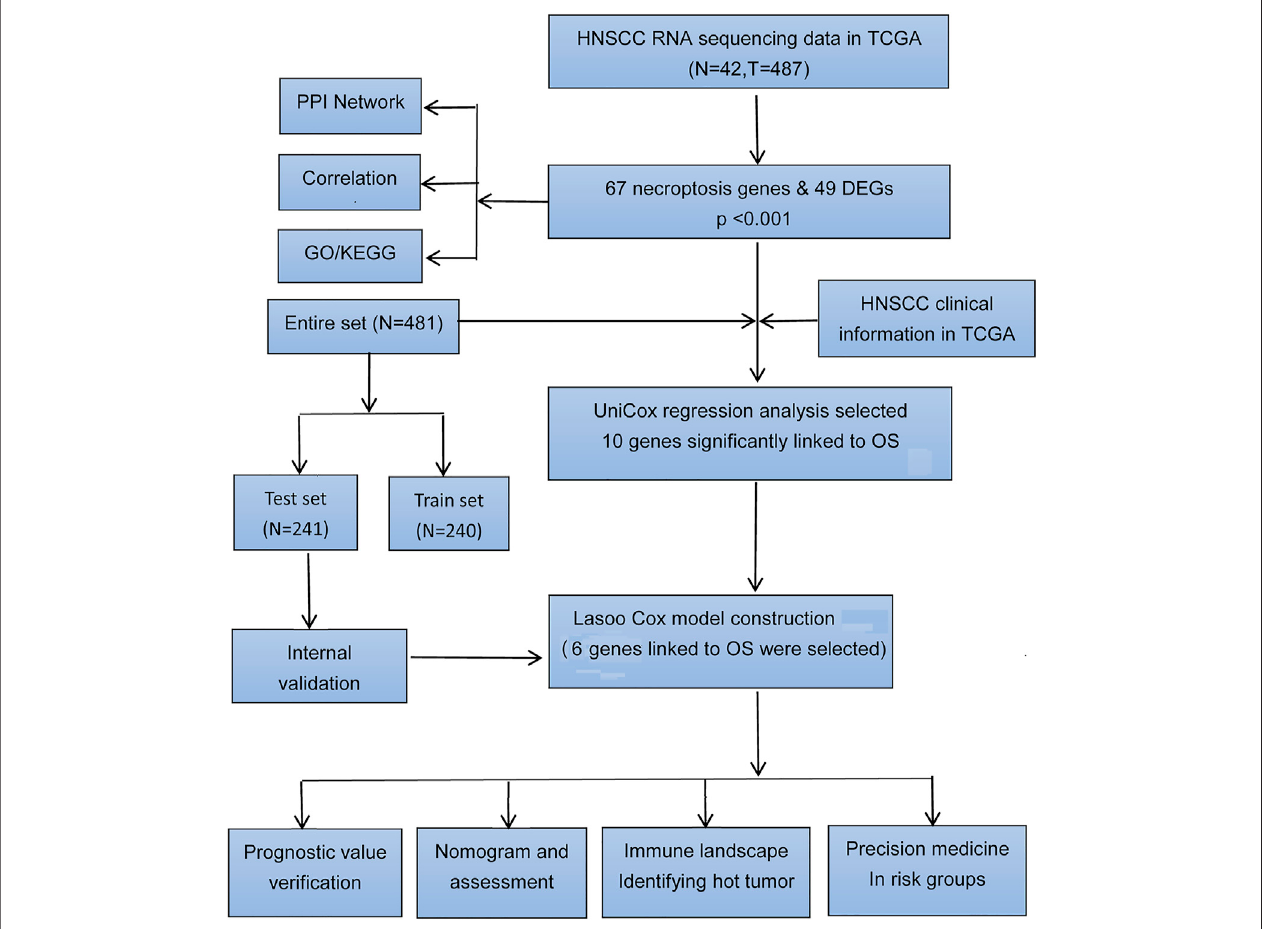
FIGURE 1 | Flow diagram of the